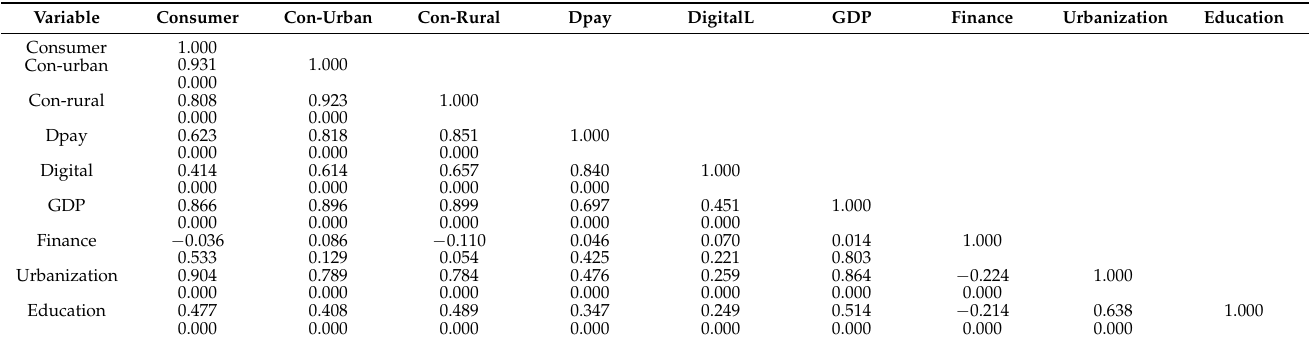
Table 3. Correlation